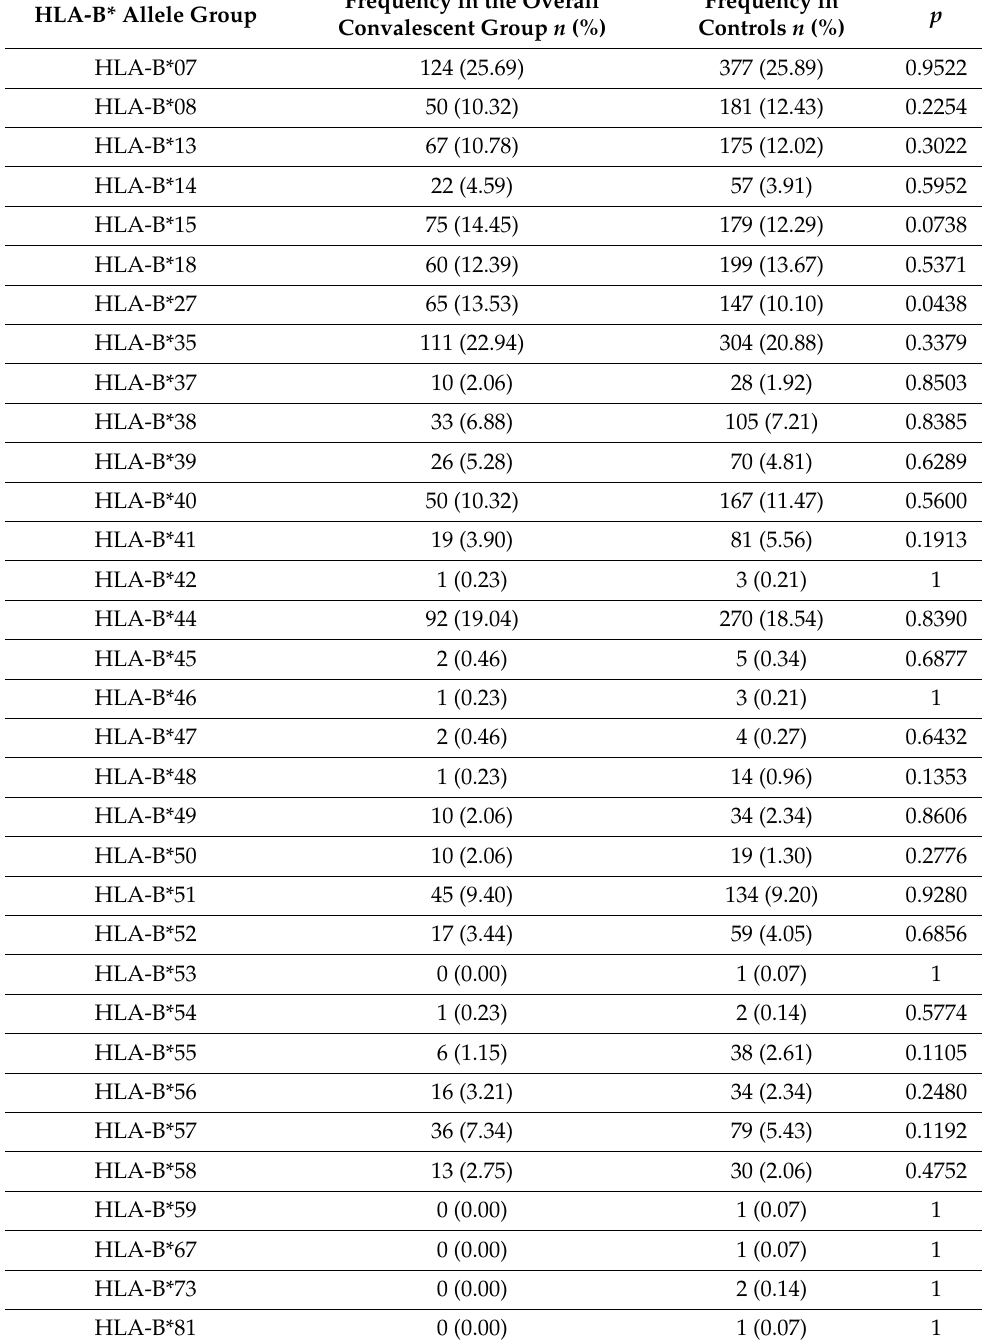
Table 2. Frequency of HLA-B* allele groups among the overall COVID-19 convalescent group ( n = 484) compared with controls ( n =